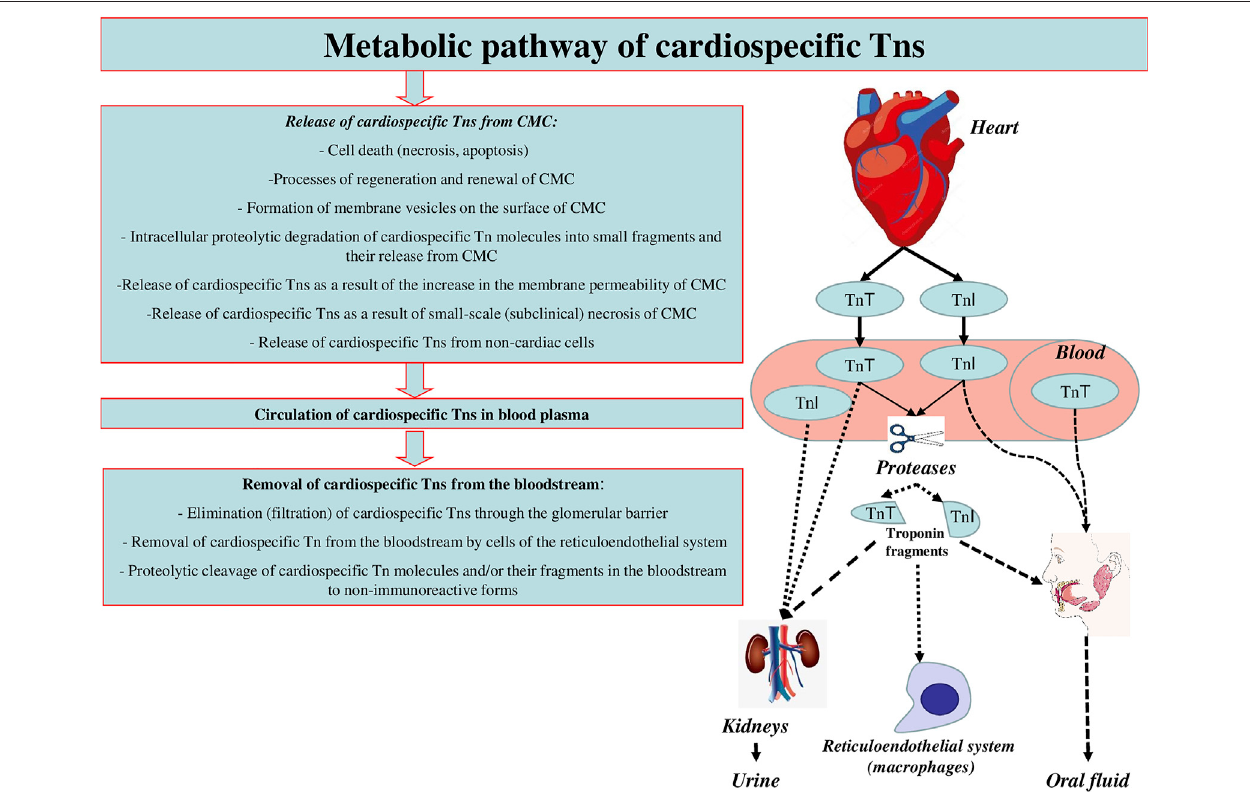
FIGURE 2 | Metabolic pathway of cardiospeci fi c